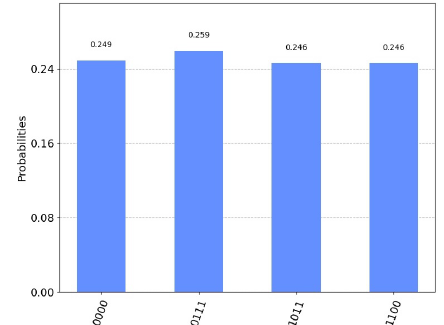
Figure 12. Probability distribution of the output configurations for the 2 × 2 case. According to Qiskit’s convention of representing the registers from the least to the most significant bits, the first two bits of the bin labels correspond to movements and the last two bits are associated with the starting